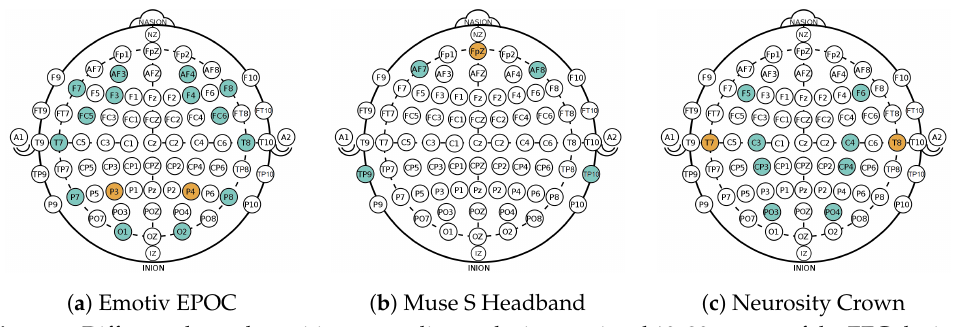
Figure 1. Different electrode positions according to the international 10–20 system of the EEG devices used in Dataset I ( a ) and in Dataset II and III ( b , c ). Sensor locations are marked in blue, references are in orange.